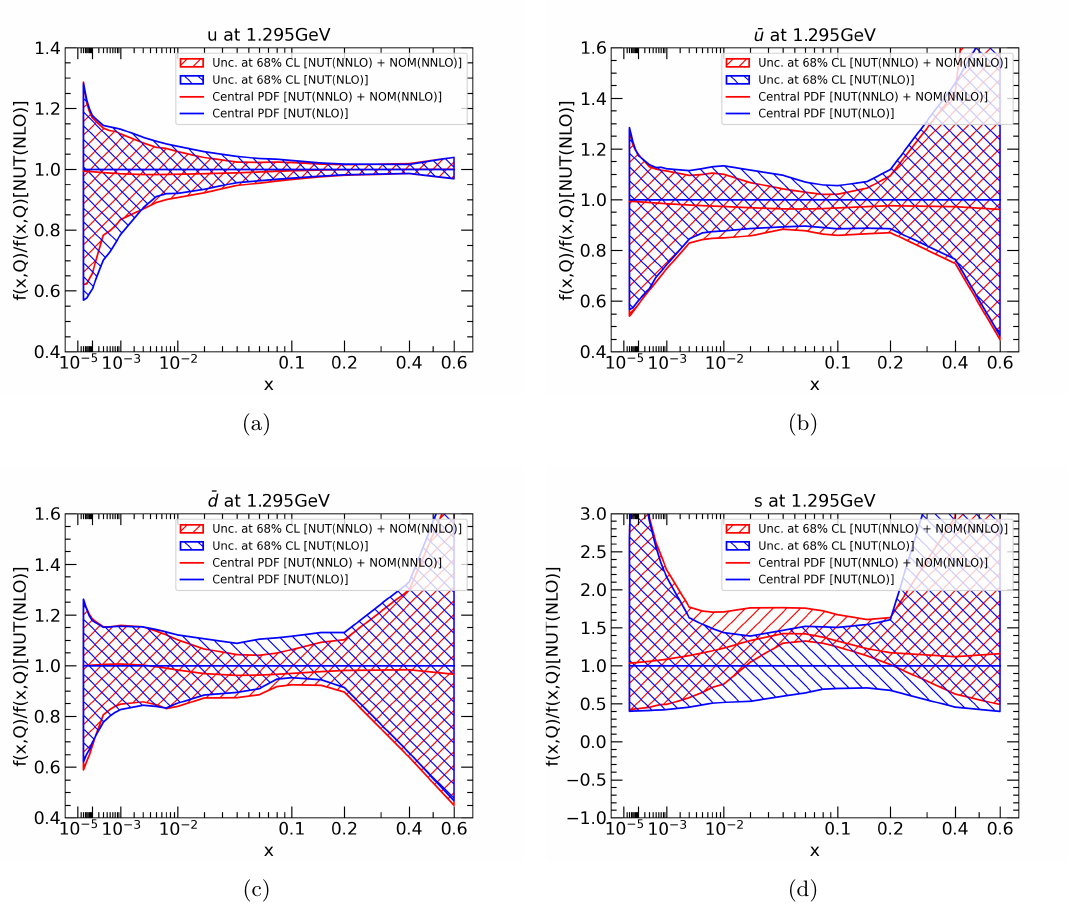
¯ d , and s . The red and the